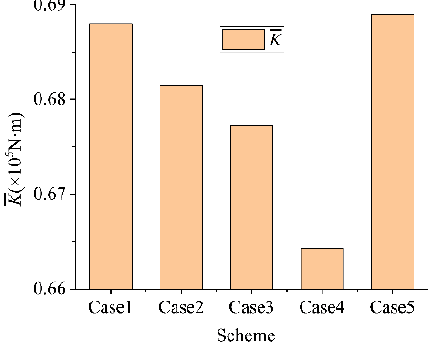
Figure 9. Comparison of K in the five cases.